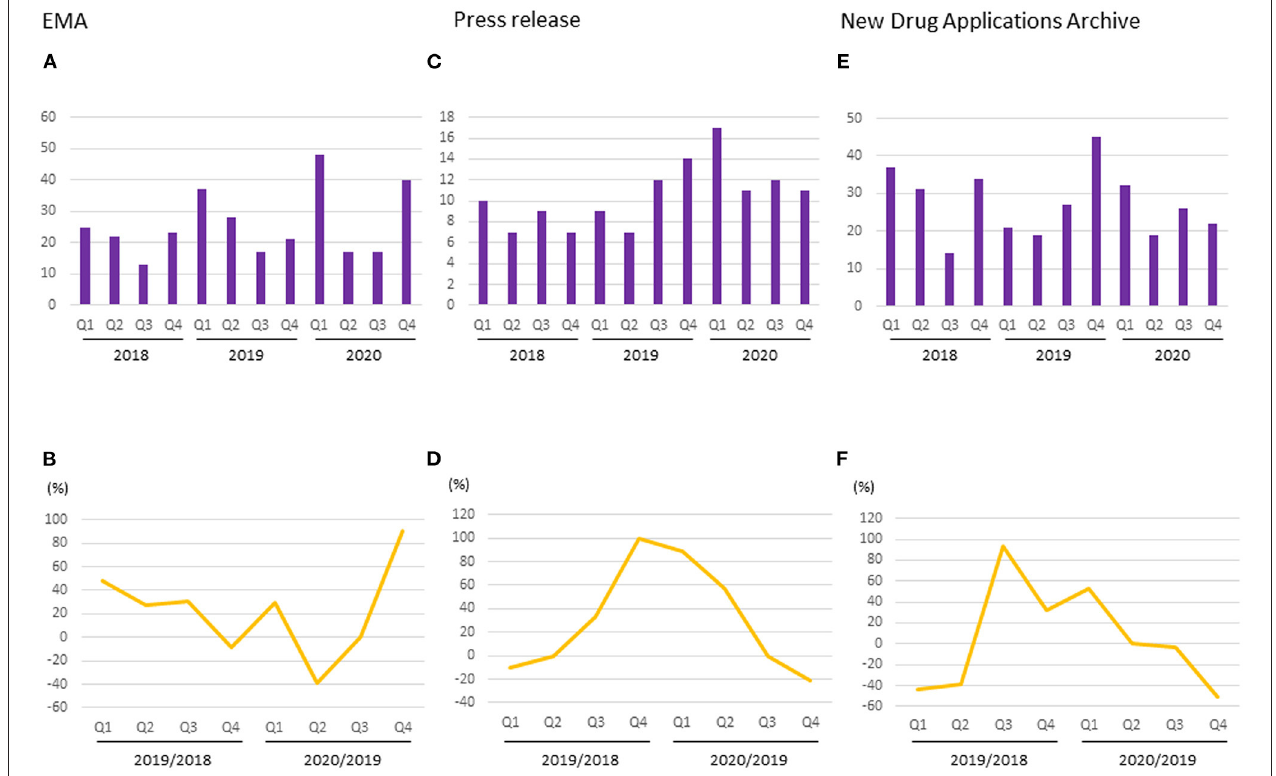
FIGURE 5 | Number and percentage change of new drug applications to regulatory authorities. (A) Number of applications started in EMA; (B) Percentage change of applications started in EMA; (C) Number of pharmaceutical company press release regarding NDA or BLA to FDA; (D) Percentage change of pharmaceutical company press release regarding NDA or BLA to FDA; (E) Number of new drug application archives in the Drugs.com database; (F) Percentage change of new drug application archives in the Drugs.com